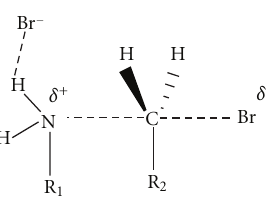
Figure 8: Transition state for the S N 2 reaction stabilized by bromide